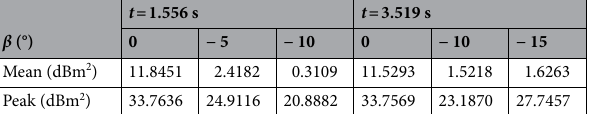
Table 6. RCS indicator of the aircraft, α = 0° ~ 360°, f RH = 6 GHz, ω m1 = ω m2 = 0.1963 rad/s.